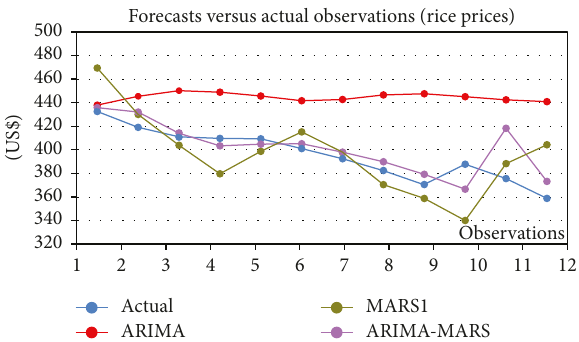
, and the proposed 1